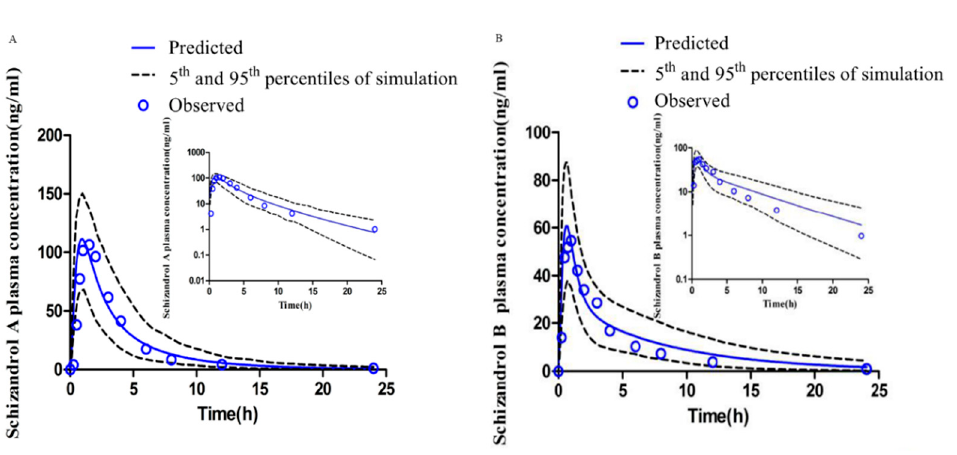
Figure 6. Simulation of plasma-concentration-time profiles of SZA ( A ) after a single oral dose of 33.6 mg and SZB ( B ) after a single oral dose of 10.8 mg in healthy Chinese patients generated by Simcyp ®